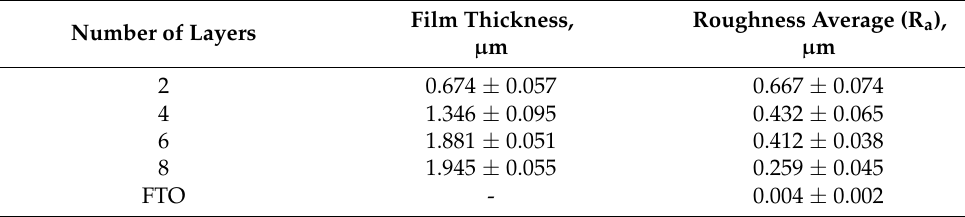
Table 1. The thickness and roughness of TiO 2 fi lms .